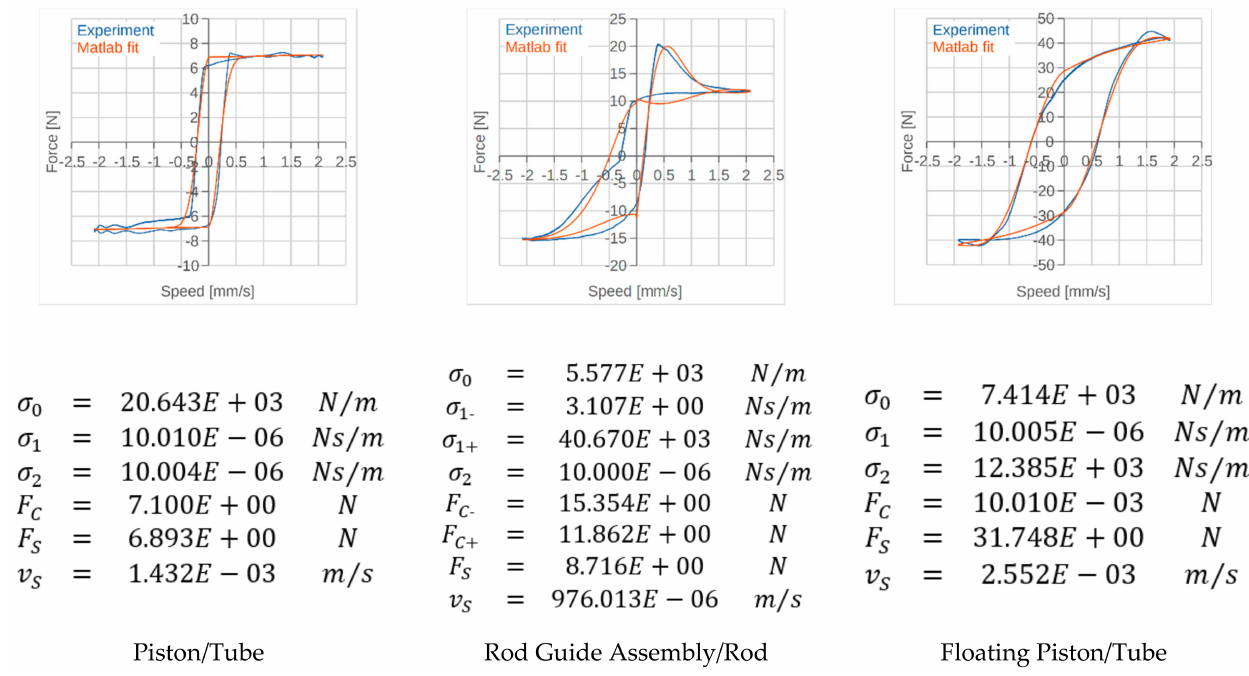
Figure A1. Parameterization results for each single friction point, showing a sufficiently accurate match of the respective force-speed